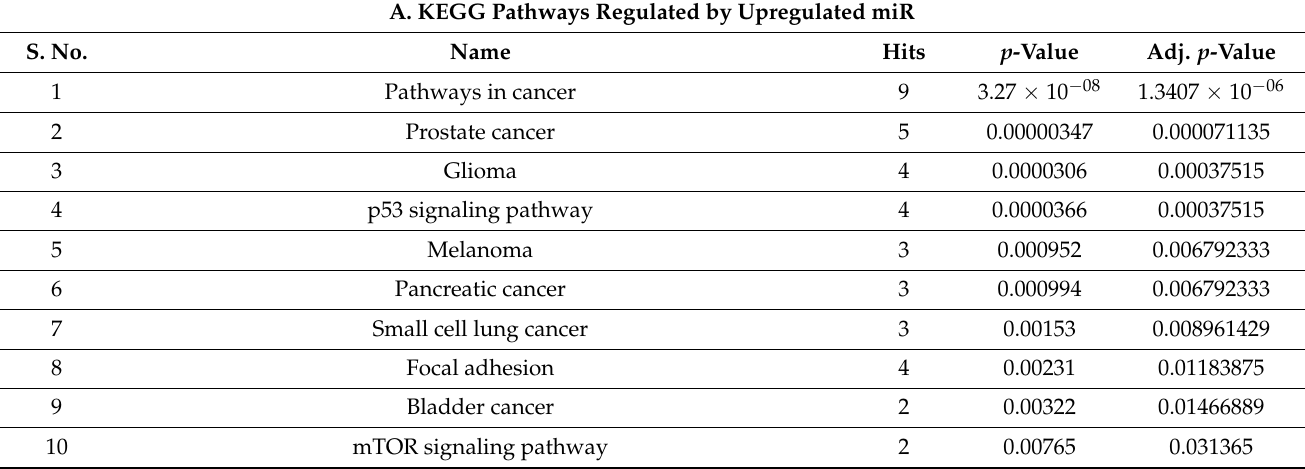
Table 4. Altered Pathways by Deregulated miR in Endometrial